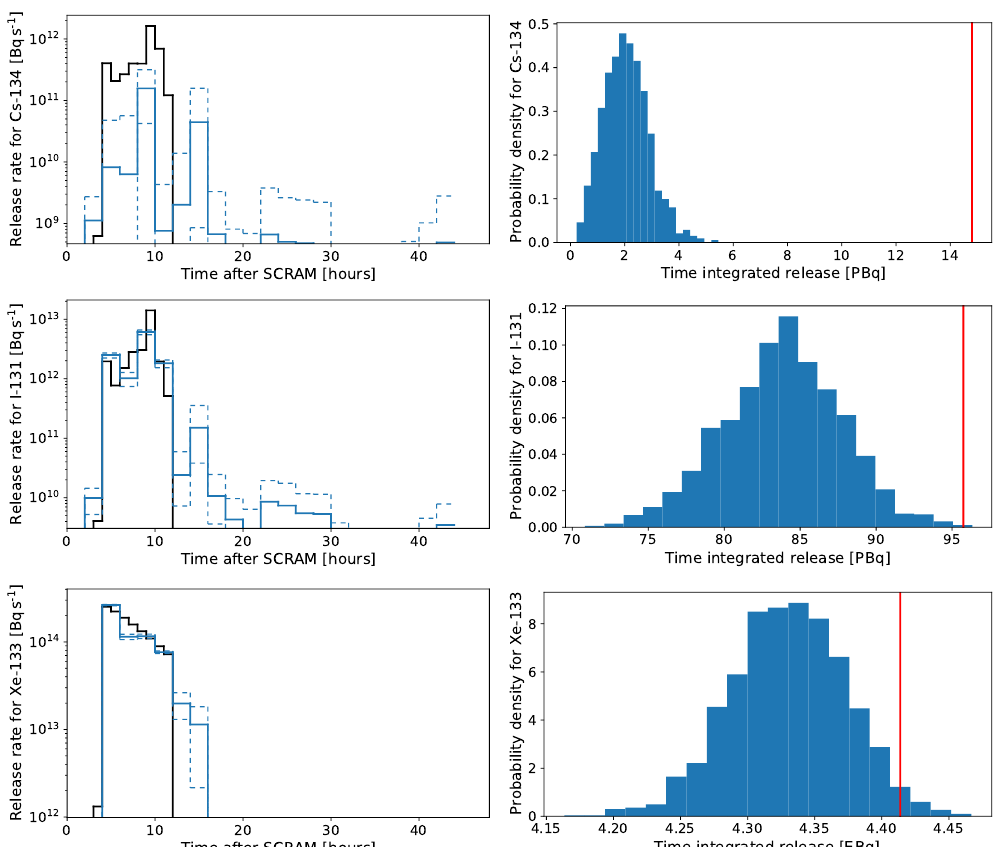
Figure 7. Release rates and probability densities for selected nuclides. For further description of the plots, see captions of Figures 2 and 3.